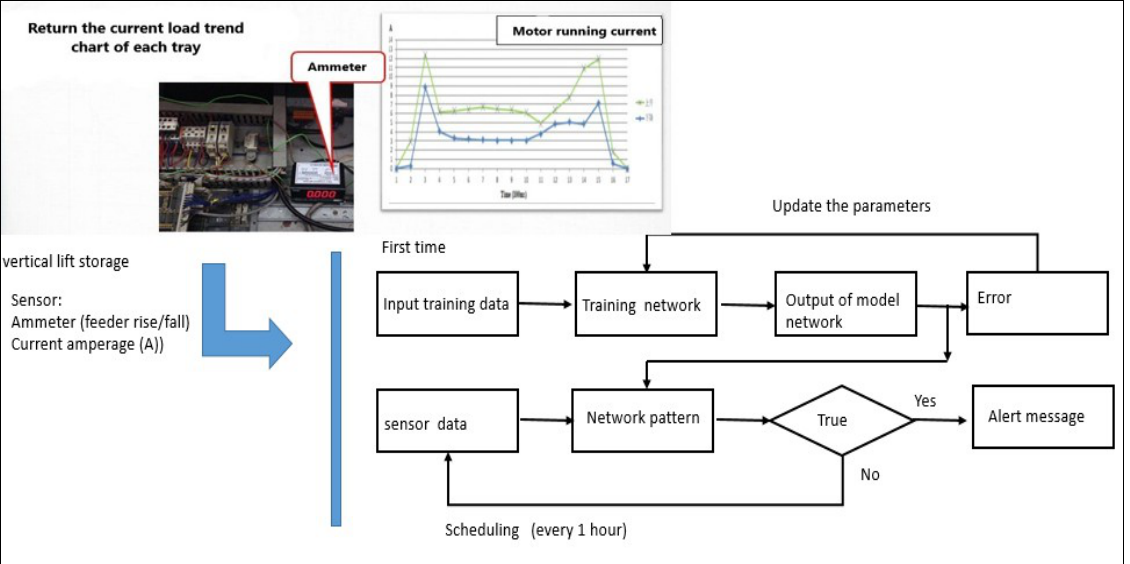
Figure 5. Prediction follows the current value of vertical lift motor.